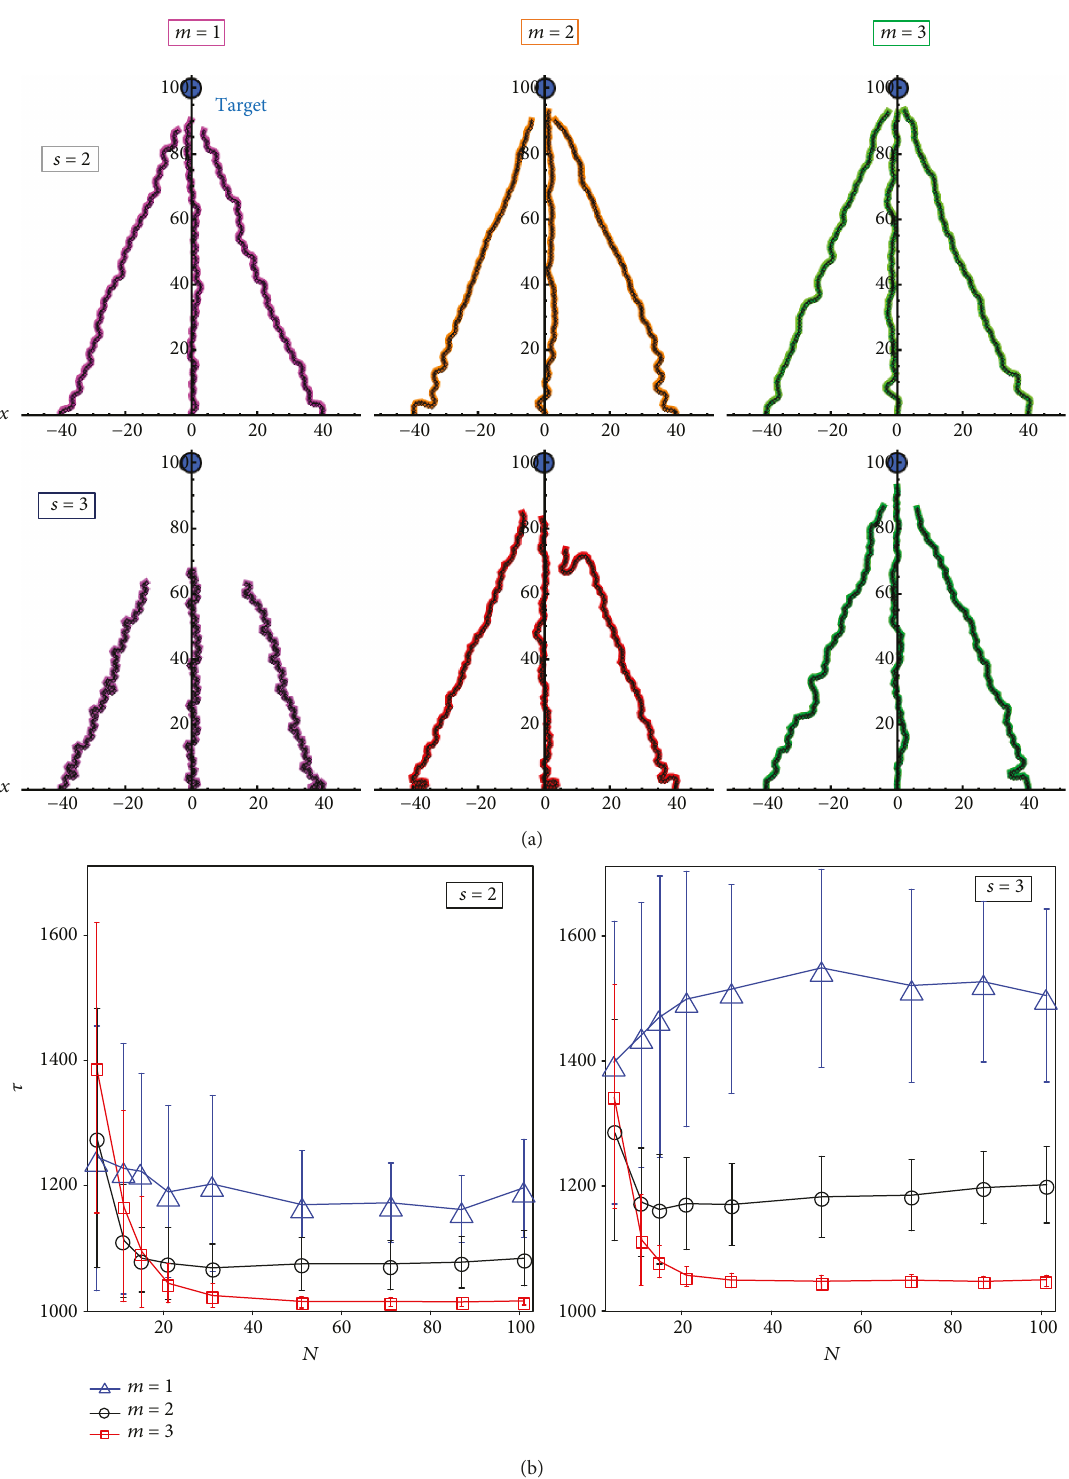
Figure 2: (a) Sample trajectories from our navigation model moving from a speci fi c point on the x axis and y = 0 , toward a speci fi c target located at the point (0, 100) in distance units of one single step ℓ . Each panel shows three trajectories for a speci fi c value of m ( m = 1 on the left, m = 2 in the middle, and m = 3 on the right) and s ( s = 2 on the top and s = 3 on the bottom). For each trajectory, the number of steps is such that the system would get to the target if traveling along a straight line. Here, the population is N = 101 . (b) Dependence of the average search time τ with the number of agents N for s = 2, 3 and m = 1, 2, 3 . Data points are averaged over 10 4 realizations with randomized initial conditions of winning history and strategy distribution. The initial system-target separation is 10 3 ℓ . Error bars are fl uctuations. For all cases, we have used δ = π /2 N